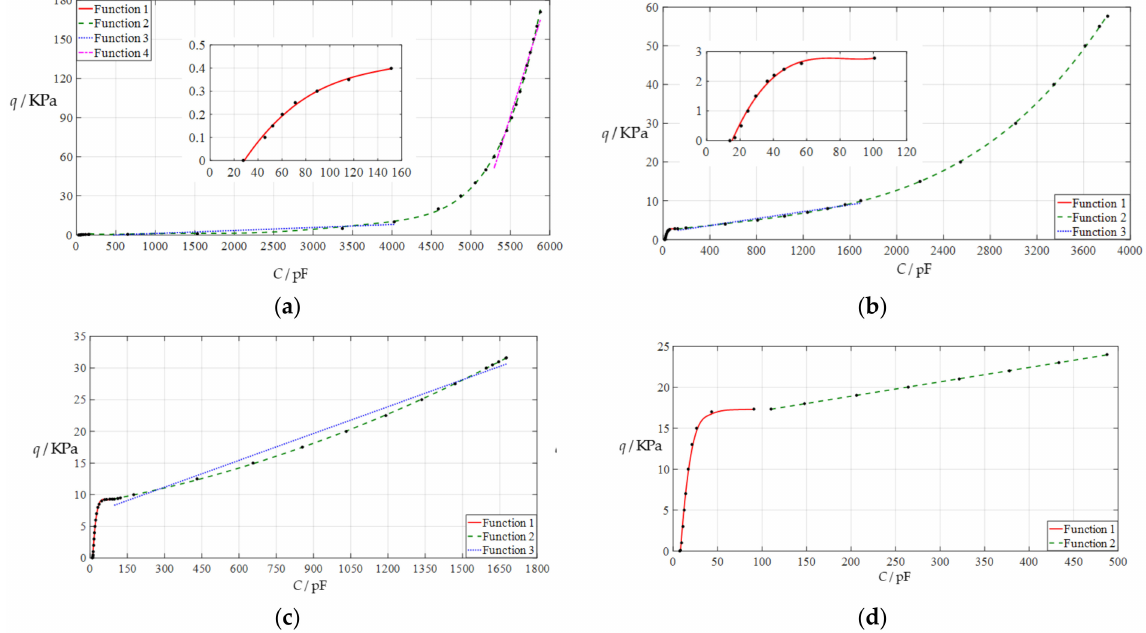
Figure 3. Least-squares fitting of the input capacitance–output pressure relationships in Figure 2: ( a ) for g = 10 mm; ( b ) for g = 20 mm; ( c ) for g = 30 mm; ( d ) for g = 37